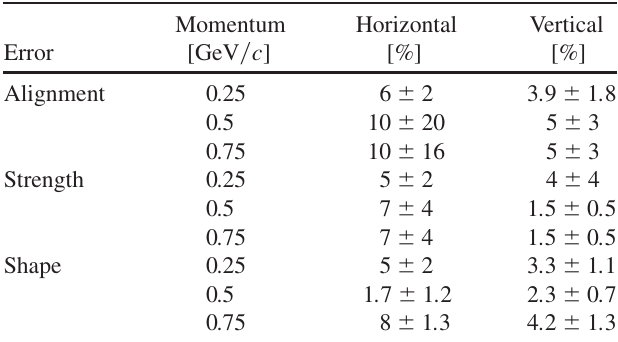
TABLE IV. Maximum growth of square root of beta functions due to 0.1 mm (sigma) alignment error or 0.1% (sigma) strength and shape errors. The data is consistent with a linear relation between the growth and errors as shown in Fig. 8.